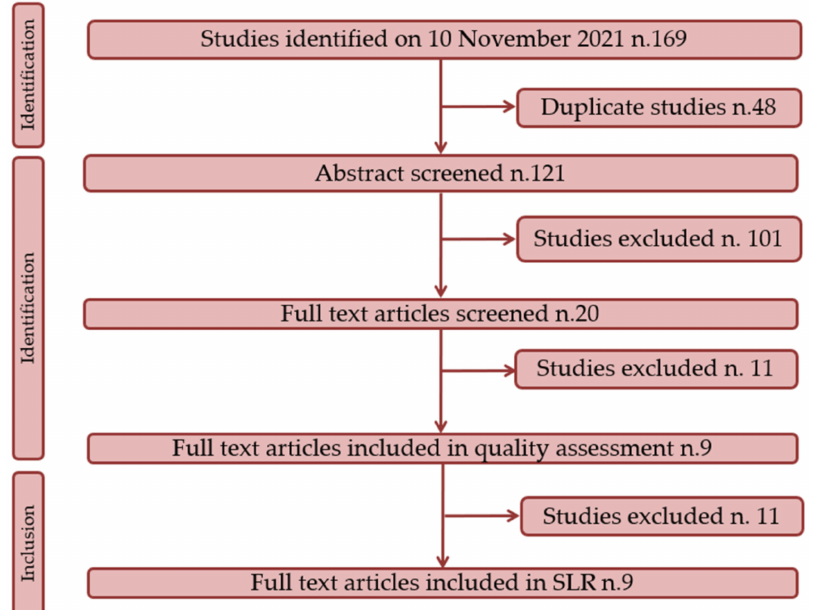
Figure 1. Graph illustrating included and excluded studies in the